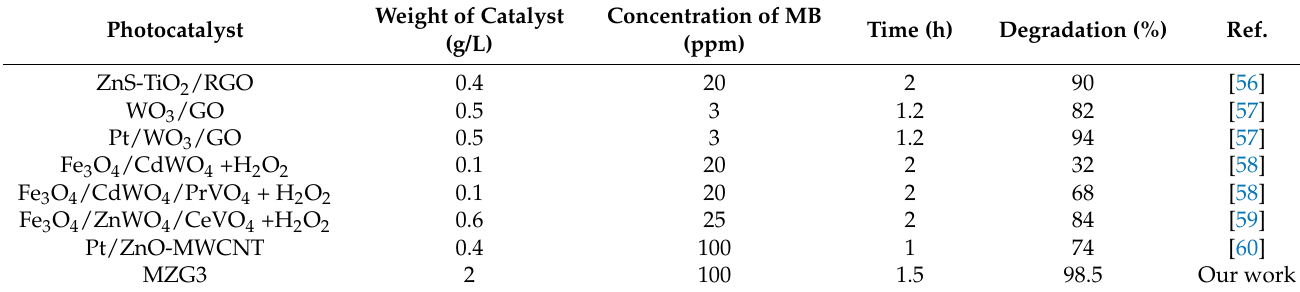
Table 2. Photocatalytic degradation of MB under visible light with various photocatalysts.